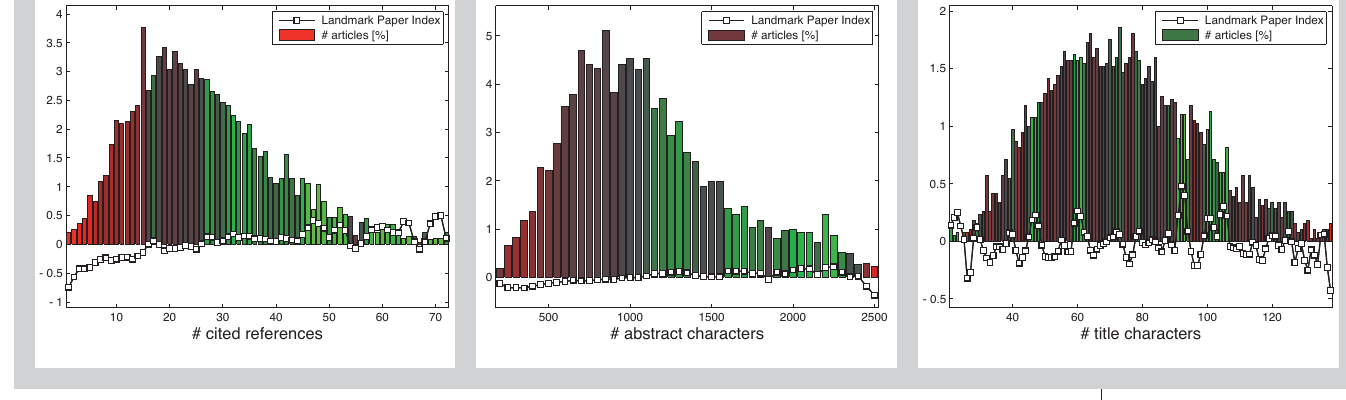
Figure 4 (left): Number of cited references and their correlation with the LPI. Figure 5 (middle): Number of characters in the abstract of scientific articles versus LPI. Figure 6: Number of characters in the title versus